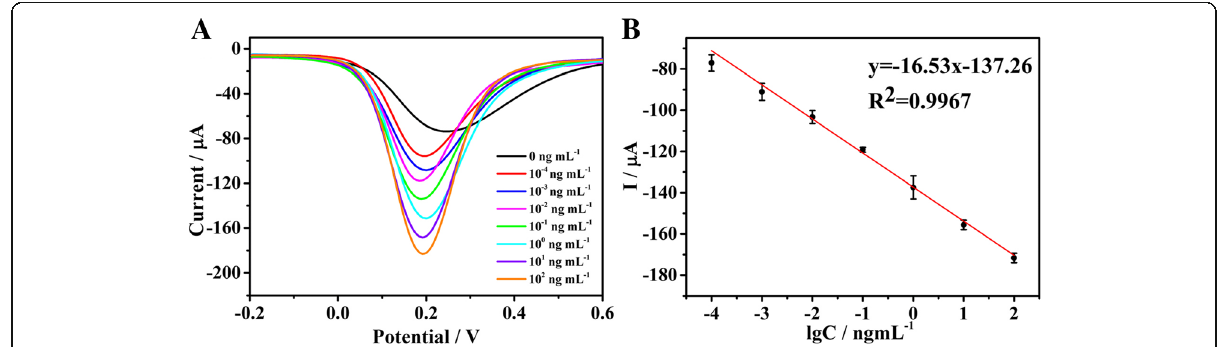
Fig. 6 a SWV responses of electrochemical detection for MMP-7 in 5 mM [Fe(CN) 6 ] 3 − /4 − phosphate buffered (0.1 M, pH = 7.4) at the concentrations from 100 fg mL − 1 to 100 ng mL − 1 . b Linear calibration curve of current and the logarithm of the concentration of MMP-7.